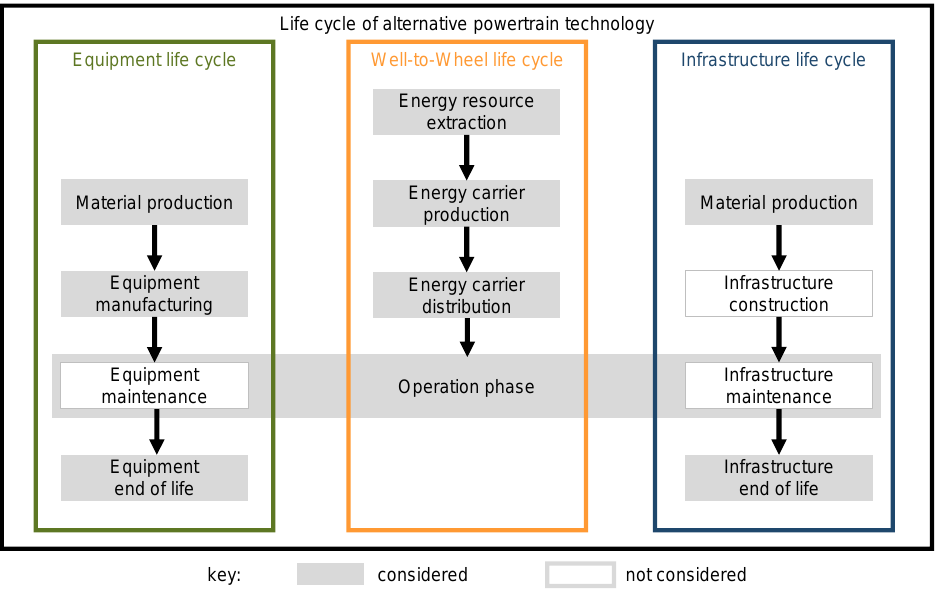
Figure 4. Life cycle of alternative powertrain technology including the consideration of infrastructure acc. [2].